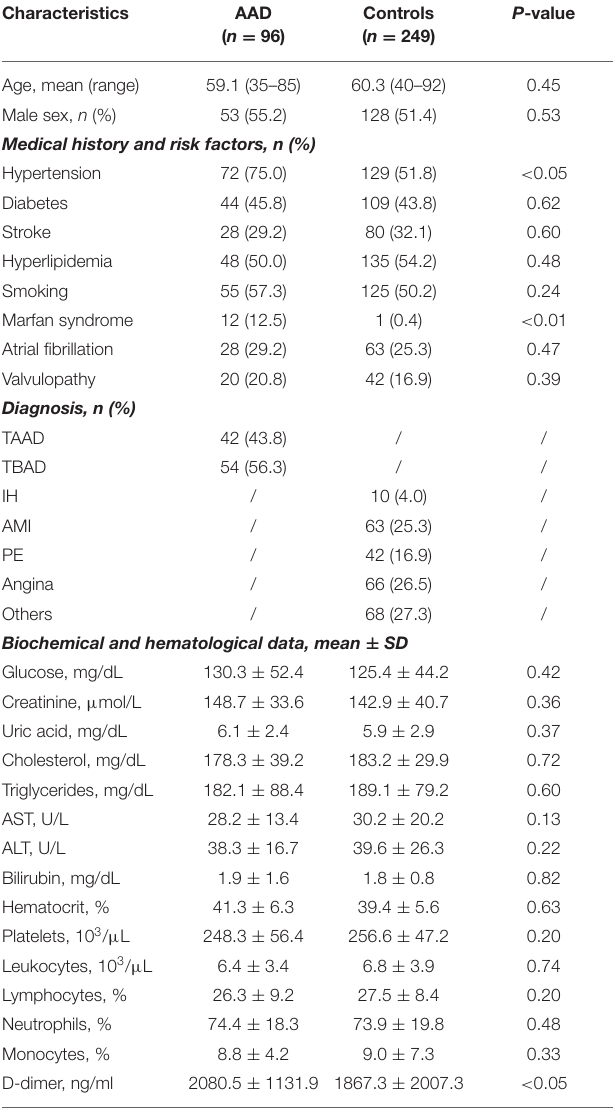
TABLE 1 | Baseline characteristics of chest pain patients included in this study.